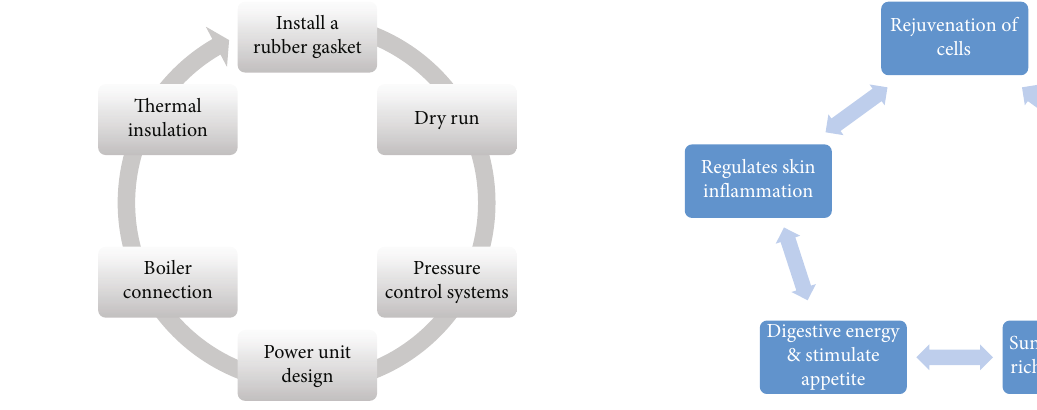
Figure 2: Proposed model fl ow. Figure 3: Enhanced energy of solar